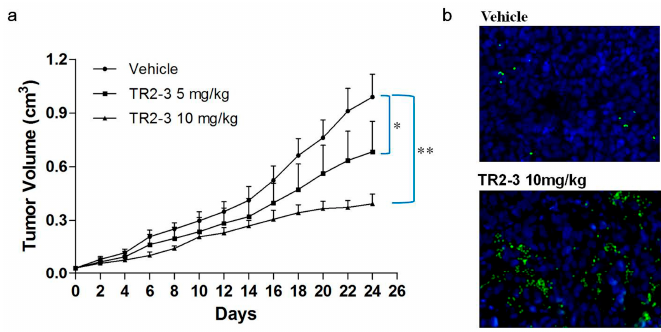
Figure 9. TR2-3 inhibits tumor growth in vivo. COLO205 cells were injected subcutaneously (1 × 10 6 cells/mouse) to BALB/c nude mice. After eight days, mice were administered PBS as a control or were administered TR2-3 (10 mg/kg) by intraperitoneal injection. ( a ) Each time point represents the mean value of the tumor size on that day as measured by a caliper ruler. Compared with the control, TR2-3 showed a statistically significant higher rate of tumor inhibition (* p < 0.05, ** p < 0.01 for the t -test); ( b ) Representative Immunofluorescence staining of cleaved caspase-3 in sections from the study in ( a ) Cleaved caspase-3 positive cells were visualized in green under a fluorescence microscope (400 × ) and the cell nuclei were stained with DAPI in blue. These data are representative of at least three independent